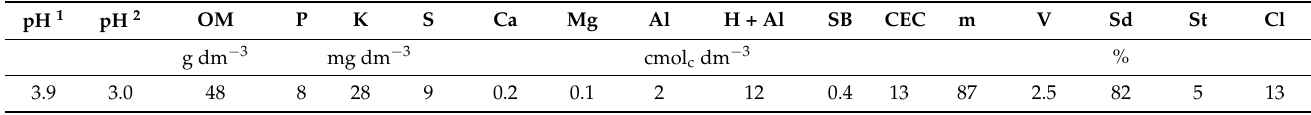
Table 2. Initial chemical and physical properties of the Yellow Latosol.